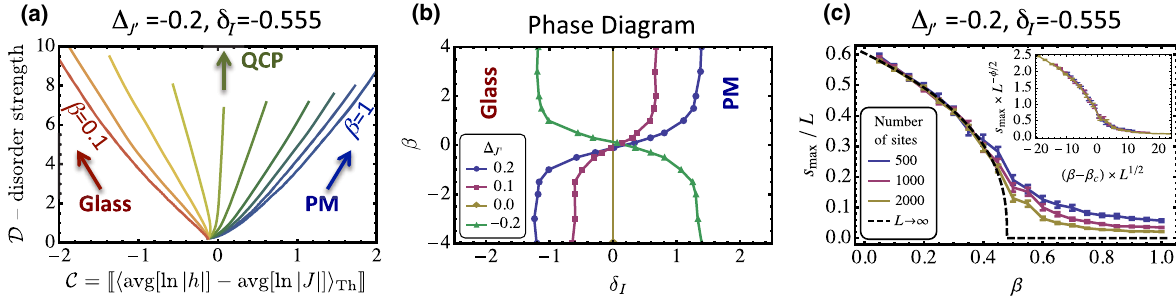
FIG. 3. (a) Renormalization group flows in the C - D plane, where C measures whether local fields or bonds are stronger while D measures the strength of disorder. Tuning β results in RSRG-X flows towards the Hilbert-glass phase, the quantum critical point, and the paramagnetic phase (PM), as indicated by arrows. (The initial value of the tuning parameter δ and the width of the initial J 0 distribution Δ is held fixed; see text.) (b) Phase diagram of the hJJ 0 model in the δ - β plane for several values of Δ J 0 s as a function of β for several values of the system size L . The transition becomes sharper and sharper as L increases. The inset shows max a finite-size scaling collapse of the same data. (Error bars indicate uncertainty due to disorder averaging; uncertainty due to Monte Carlo sampling is always